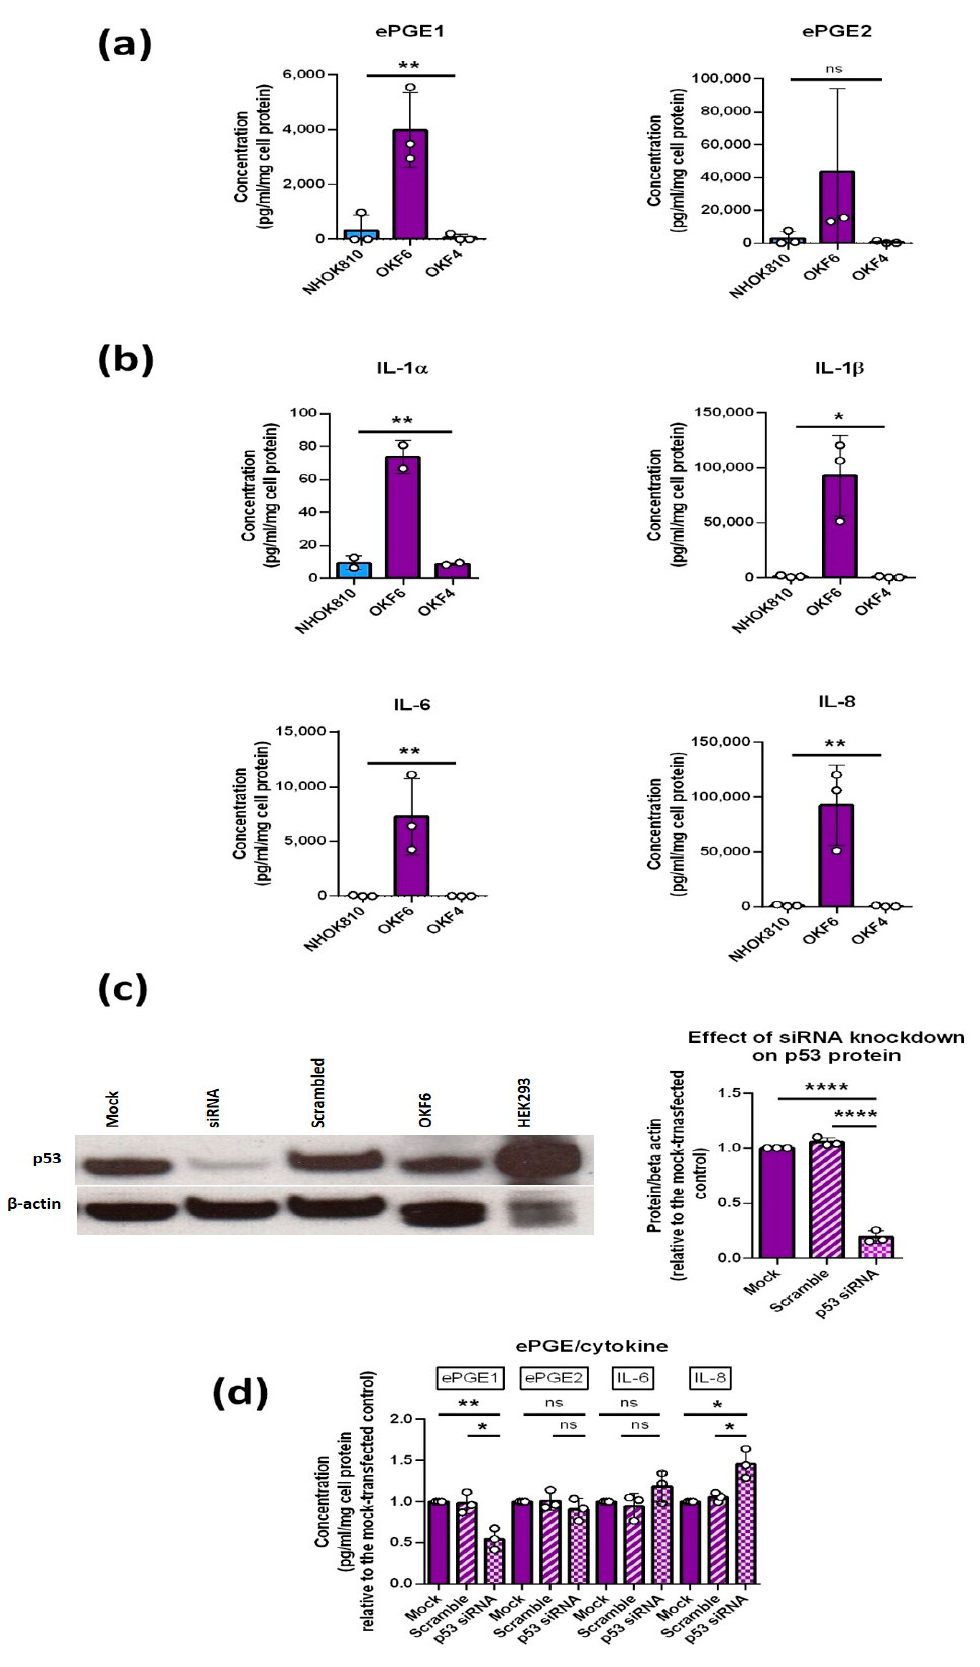
Figure 6. ePGE and cytokine regulation in OKF6 keratinocytes by p53. ( a ) Shows ePGE1 levels and ePGE2 levels in normal (NHOK810), OKF6 (p53 wild type) and OKF4 (p53 dysfunctional)